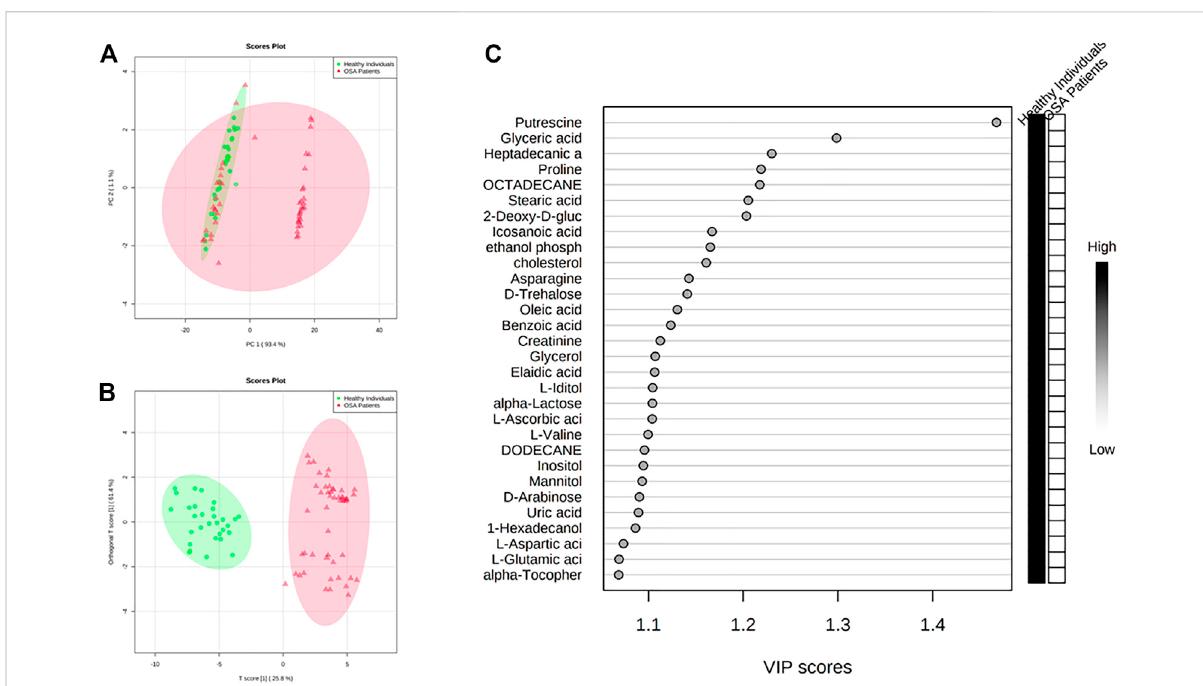
FIGURE 2 Discrimination through principal component analysis (PCA) and ortho partial least square discriminant analysis (OPLS-DA) of the metabolites patterns in controls and patients affected by OSA (A) PCA and (B) OPLS-DA plots that allowed groups discrimination by virtue of the fi rst two components (PCs); (C) VIP scores of the OPLS-DA